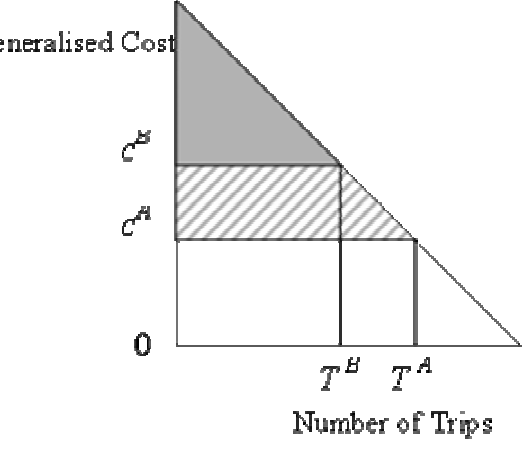
Figure 7. Rule of a half